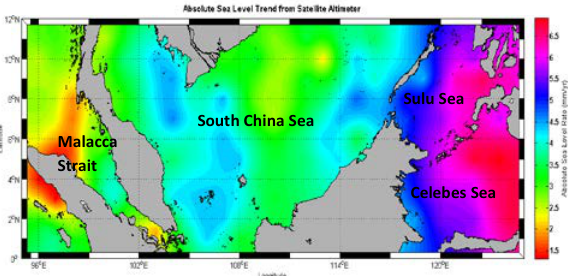
Figure 1. Map of absolute sea level trend over Malaysian